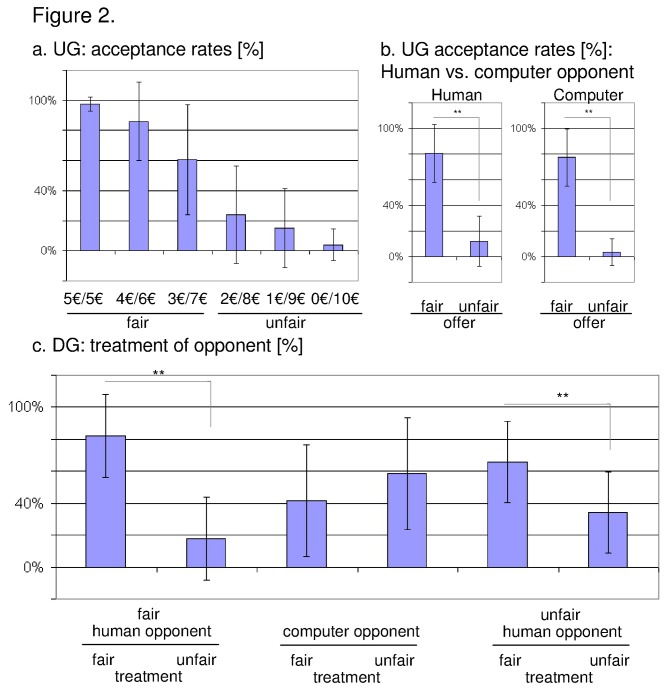
Behavioural data derived from the (a) ultimatum game and from the (b) dictator game.a. Acceptance rates in percent categorized according the amount of money offered to the subject. Furthermore, acceptance rates for fair offers, i.e. five €-, four €, and three €-trials, and unfair offers, i.e. two €-, one €-, and zero €-trials, were presented on the right side of the diagram.b. Treatment of opponents in the dictator game.Concerning the dictator game, we calculated the ratio (expressed in percent) between the number of trials representing a fair treatment of a previously fair player, unfair treatment of a fair player, fair treatment of a computer player, unfair treatment of a computer player, unfair treatment of an unfair player, and fair treatment of an unfair player, respectively, and the total number of trials presented in this part of the experimental paradigm.** p < 0.01; * p < 0.05. Error bar represents standard deviation.